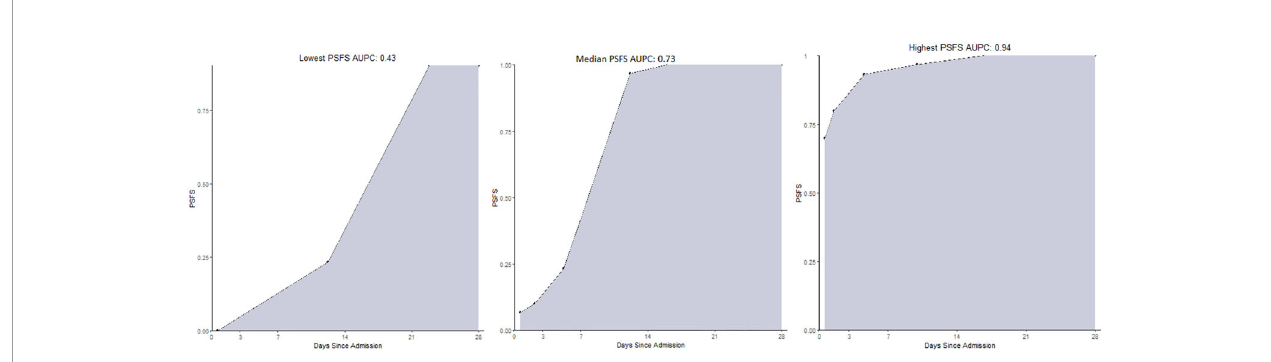
FIGURE 1 | The range of the Patient-Speci fi c Functional Scale Area Under the Patient Curves at 28 days for 24 patients with available preliminary data. (examples lowest, median, highest). PSFS AUPC, Patient-Speci fi c Functional Scale Area Under the Patient